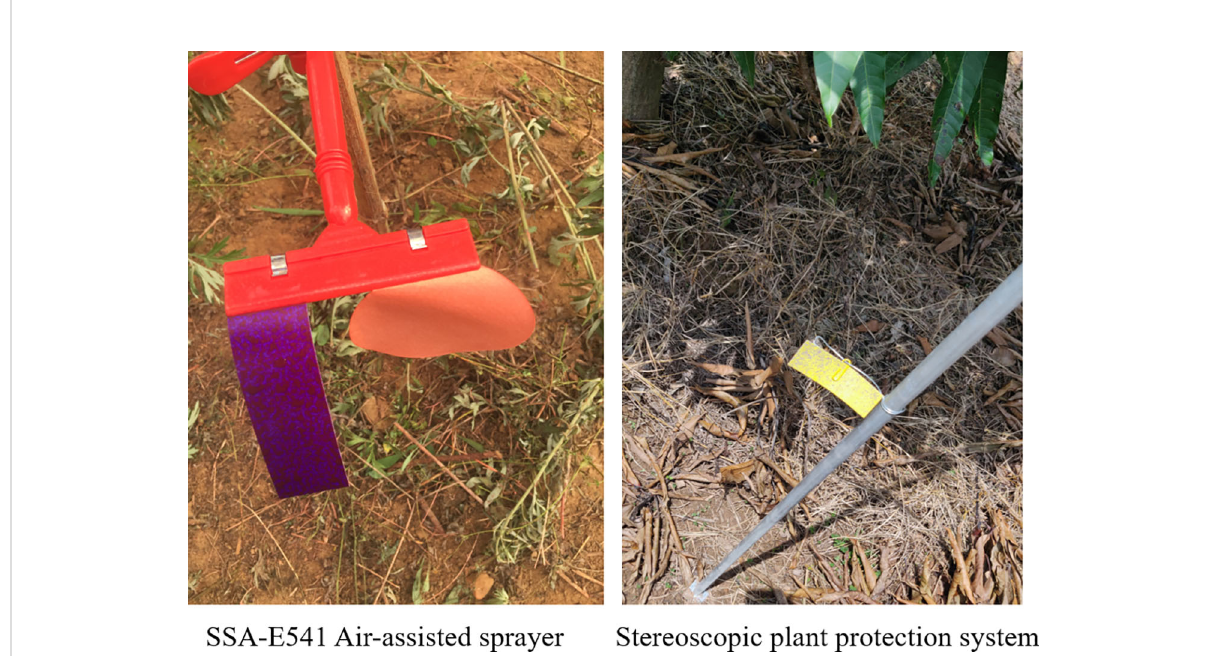
FIGURE 15 Comparison of ground